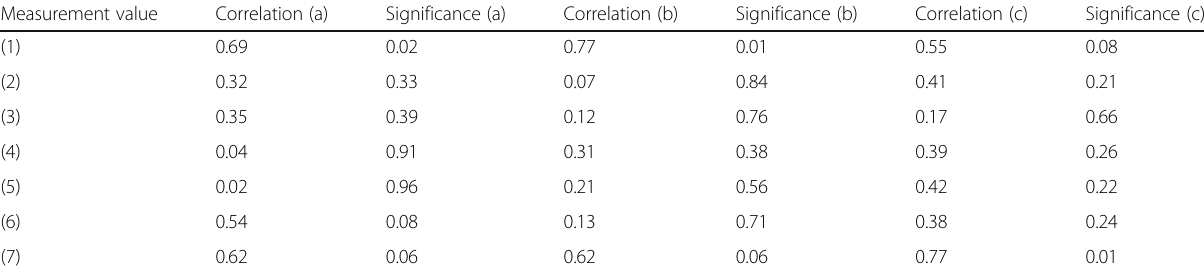
Table 3 Correlation analysis of the mean absolute differences was performed by a paired t test for the comparison of the different positioning techniques among each other: (a) positioning I versus II, (b) positioning I versus III, (c) positioning II versus